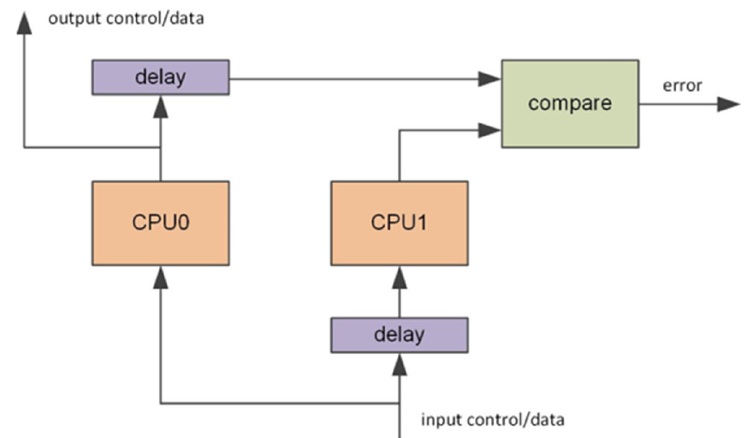
Figure 1. Block diagram of a typical dual-core lockstep processor.